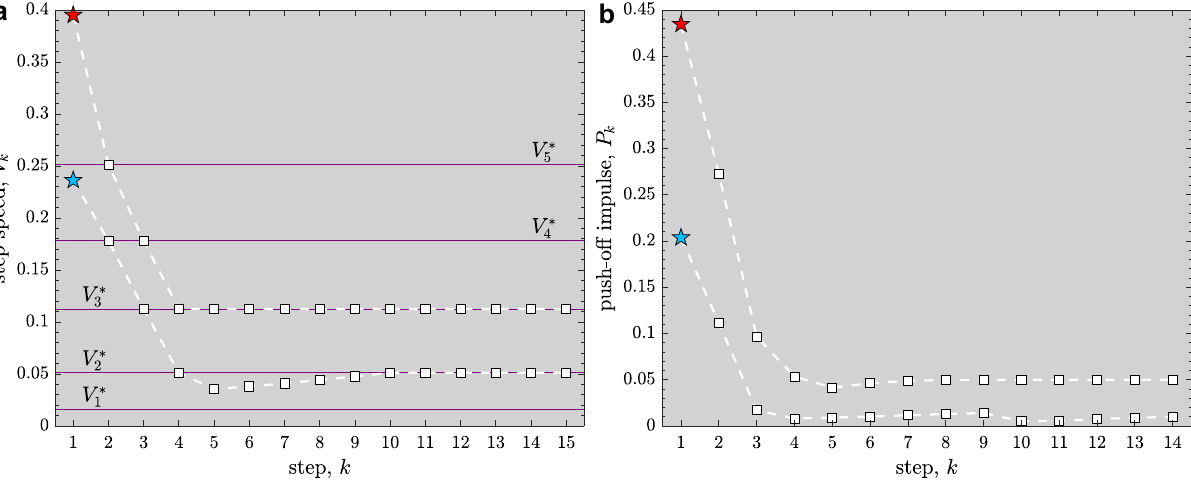
Figure 8. The sequences of step speeds V k ( a ) and corresponding push-offs P k ( b ) during the walker’s recovery (in two example scenarios depicted in Fig. 7) from large disturbances via task switching control of speed regulators. The walker’s speed rapidly switches to the target speed V ∗ f in three steps so that V 4 = V ∗ f : in example 1 ( star pentagon, red ), V ∗ f = V ∗ 3 ; while in example 2 ( star pentagon, blue ), V ∗ f = V ∗ 2 . Subsequently, in example